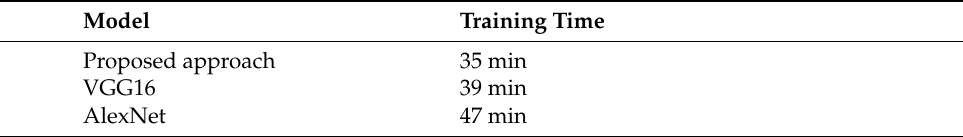
Table 8. Statistics for required training time for classifiers.